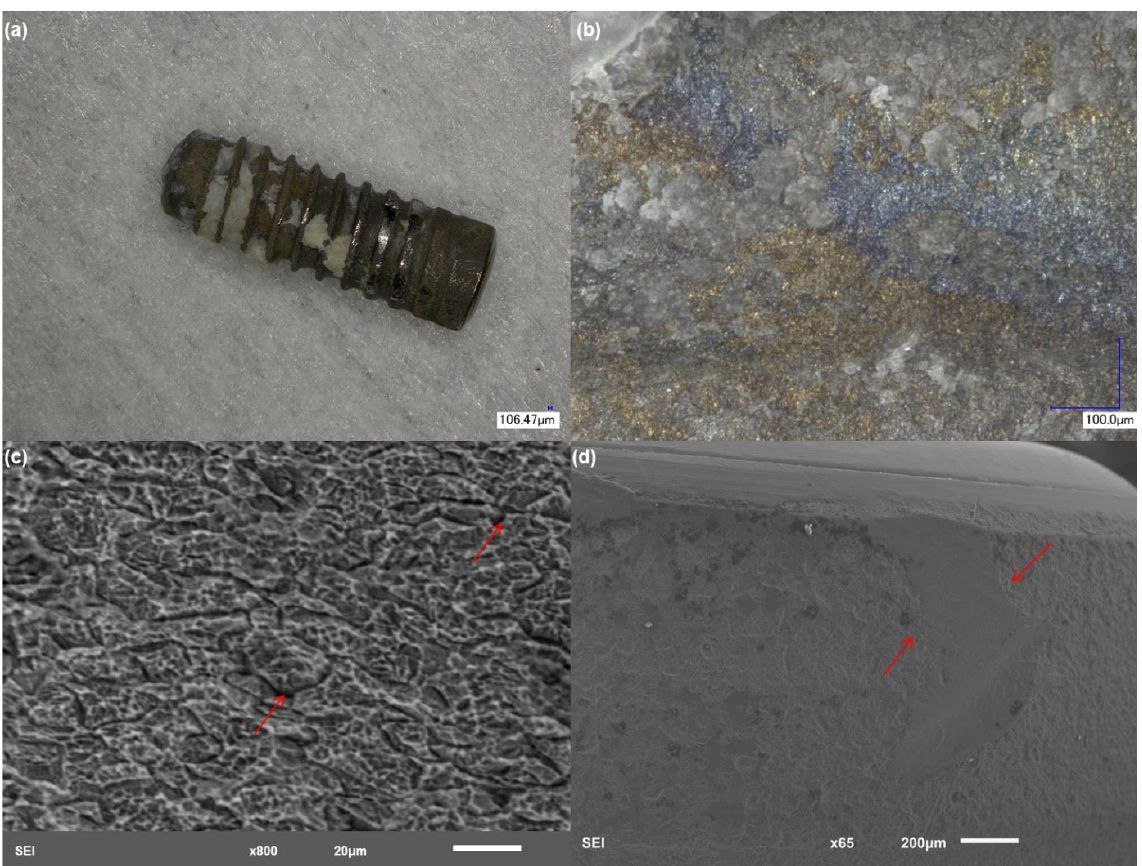
Figure 3. Structure of implant 2. ( a ) Low magnification showing the gross features of the implant; ( b ) discoloration is evident at a higher magnification. The violet and yellow discoloration indicates oxidation of Ti; ( c ) implant rough interface demonstrating severe cracking, which probably led to bulk exposure; and ( d ) higher magnification with removal of the top layers of the metal (arrows) in the top region of the